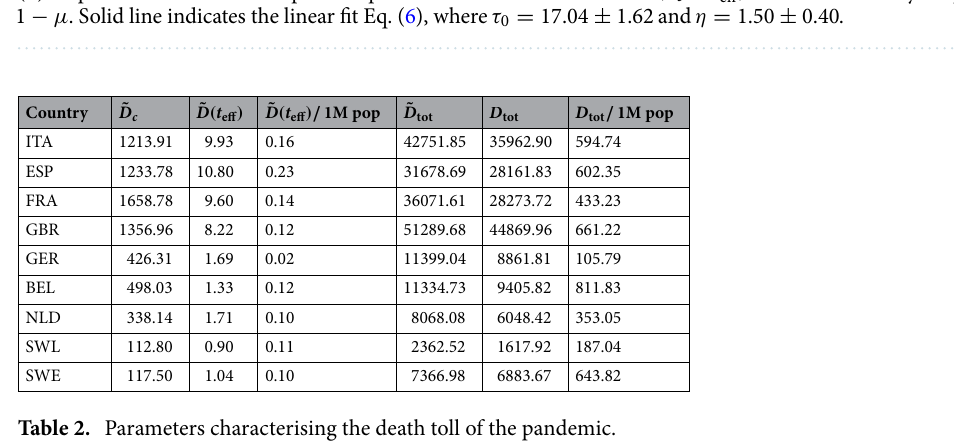
Table 2. Parameters characterising the death toll of the